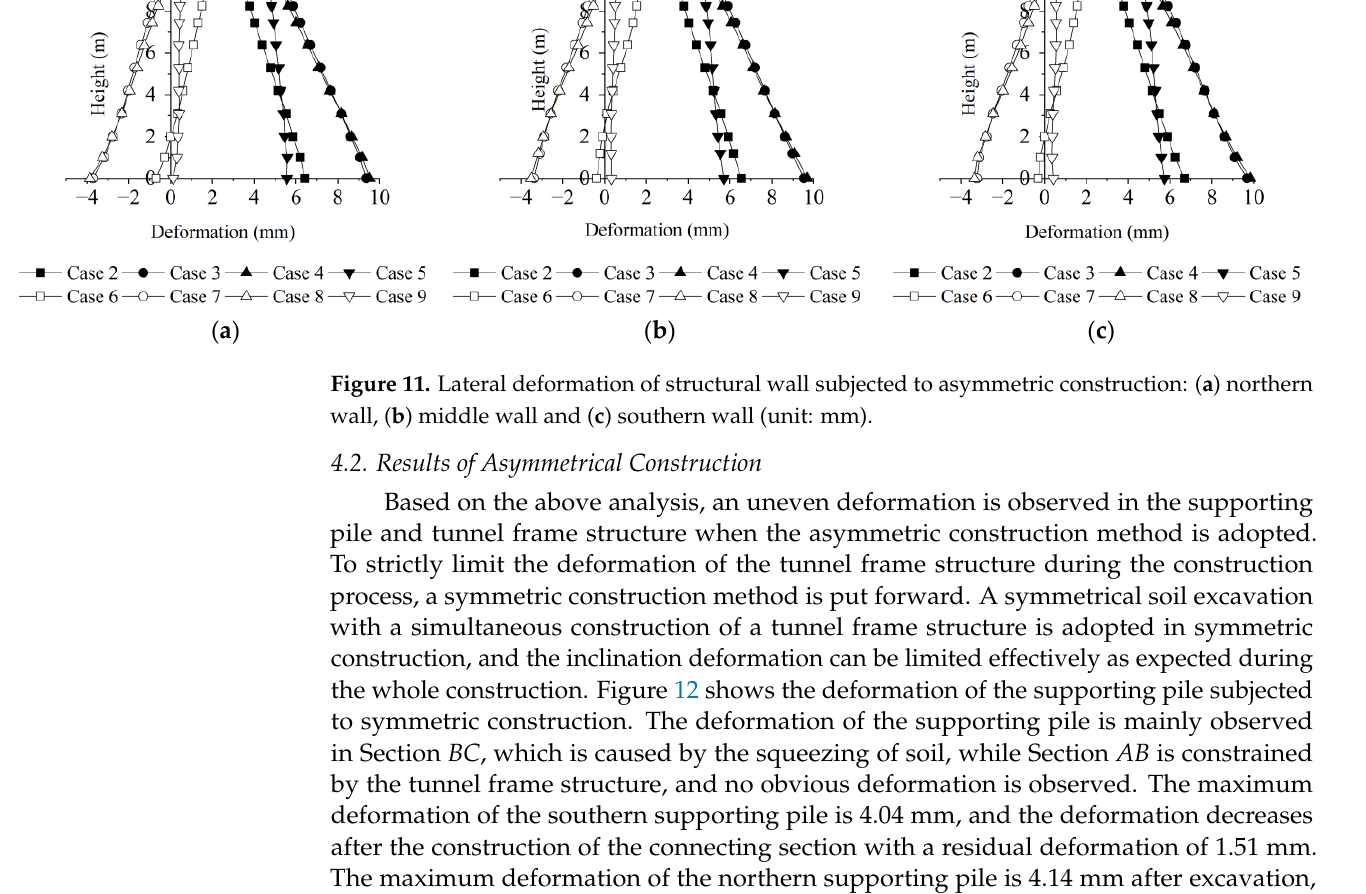
Figure 10. Vertical deformation of structural slab subjected to asymmetric construction: ( a ) bottom slab and ( b ) top slab (unit: mm).